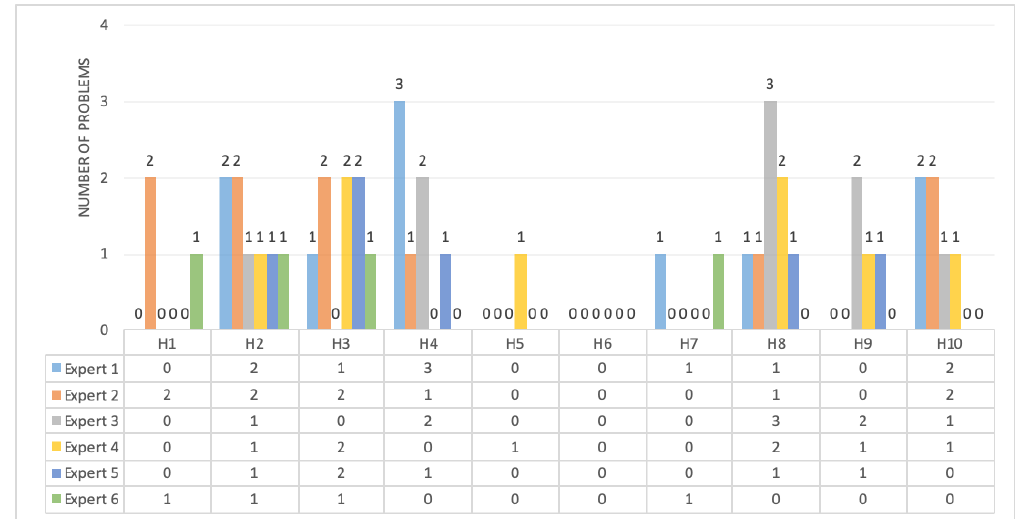
Figure 4. Distribution of problems in heuristics.